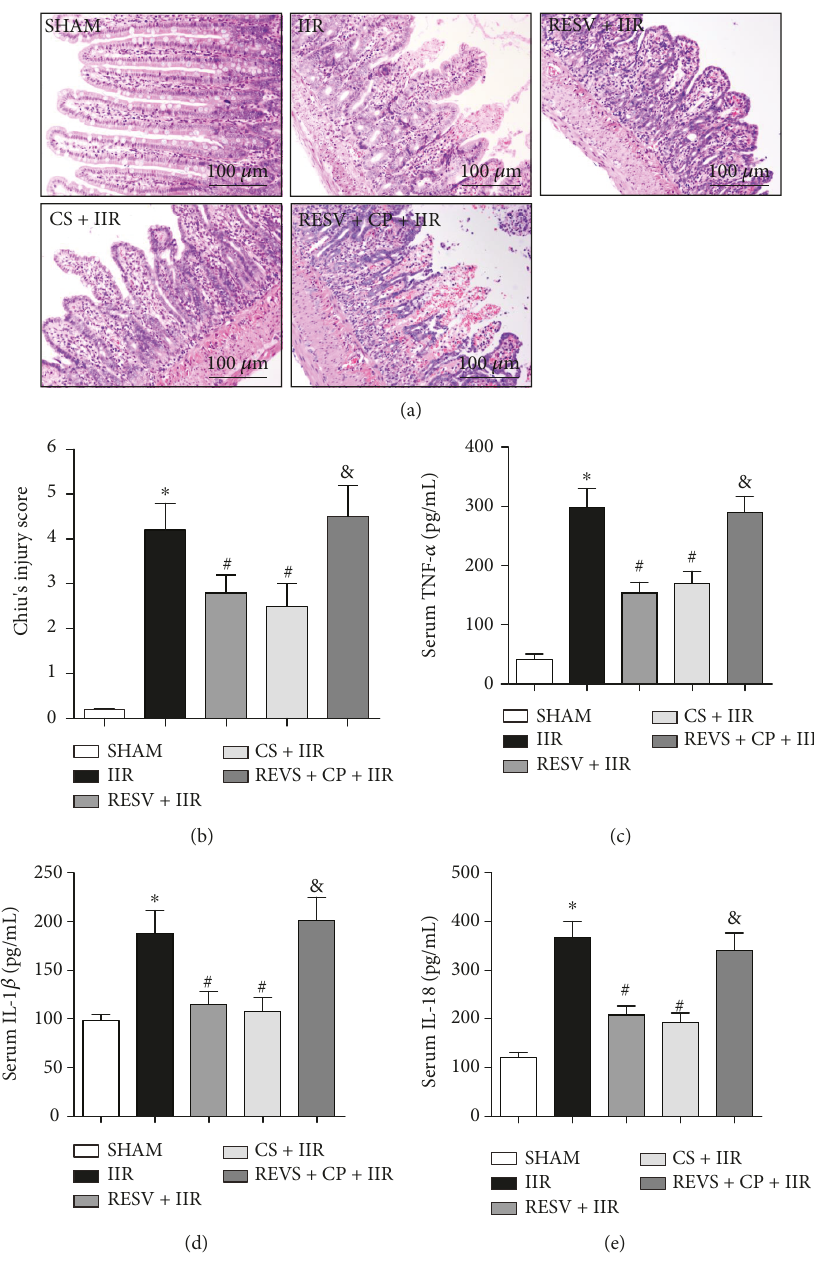
Figure 1: Resveratrol pretreatment attenuated IIR injury and reduced proin fl ammatory cytokine generation. (a) Representative histological illustration for each group, hematoxylin and eosin (H&E) staining, magni fi cation: × 200. (b) Chiu ’ s score. (c) Serum TNF- α activity. (d) Serum IL-1 β activity. (e) Serum IL-18 activity. IIR: intestinal ischemia-reperfusion; RESV: resveratrol; CP: compound 48/80; CS: cromolyn sodium. Data are expressed as the means ± SEM, n = 8 /group. ∗ P < 0 05 vs. sham group, # P < 0 05 vs. IIR group, & P < 0 05 vs. RESV+IIR